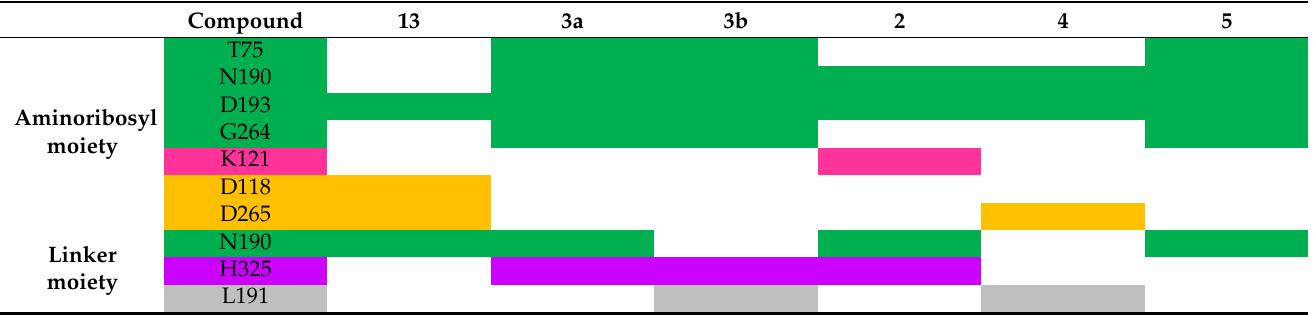
Figure 6. Predicted binding mode of compounds to MraY AA from docking in model 6OYH. Three- dimensional representation ( A ) and 2D diagram of interactions ( B ) for compound ( S , S )- 3a . Three- dimensional model ( C ) and 2D diagram of interactions ( D ) for compound ( R , R )- 3b . Ligands and residues are shown in stick mode. Interactions are indicated by colored dashed lines: conventional hydrogen bond (green), electrostatic interactions (orange), and π – π and amide– π interactions (magenta). The hydrogen atoms of apolar groups were omitted for clarity. Table 4. MraY AA binding-site hotspots (PDB: 6OYH) for the aminoribosyl and linker moieties of hits.